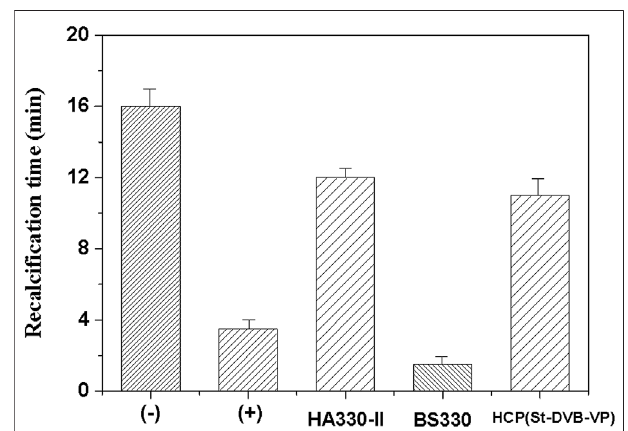
FIGURE 10 | Hemolysis ratio of the controls and adsorbents. hemolysis test: (+) deionized water, ( − ) PBS solution. The data are expressed as the mean ± SD of three independent measurements.